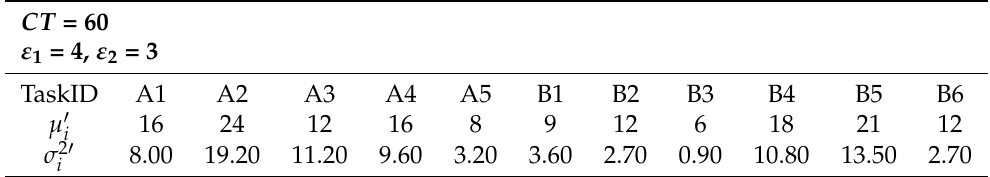
Table 4. The modified information of product A and B on parallel disassembly lines.